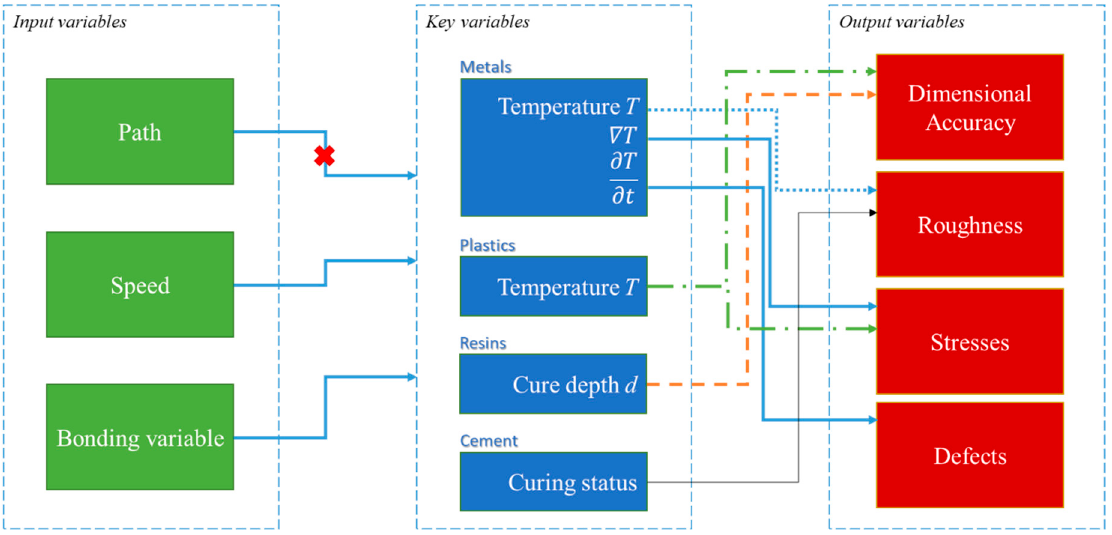
Figure 5. Abstractive metamodeling in AM.